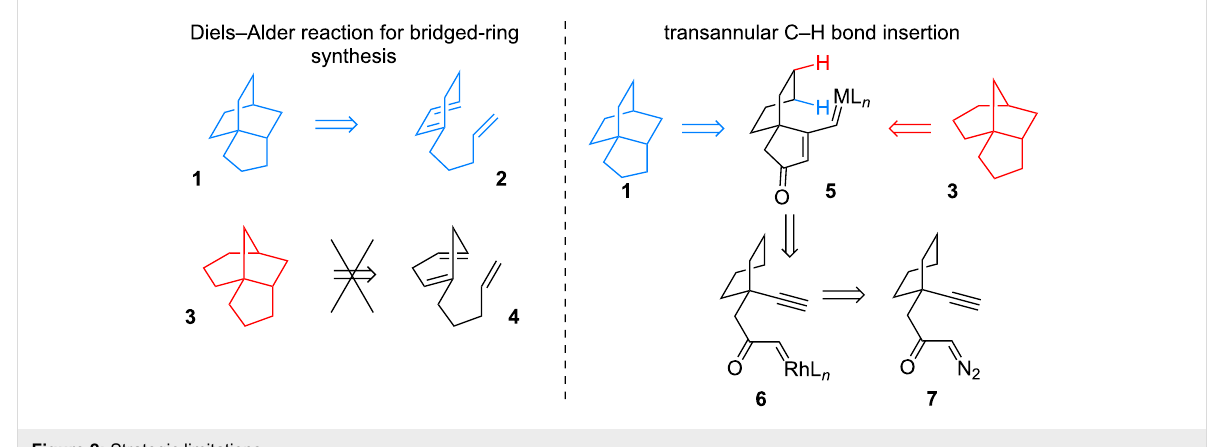
Figure 2: Strategic